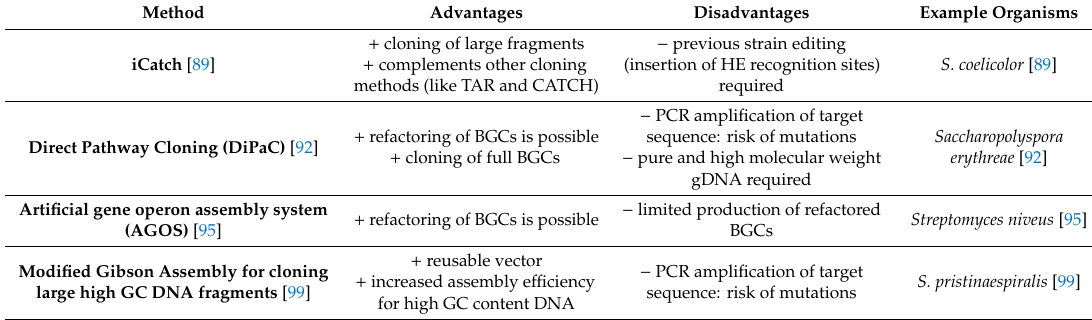
Table 1. Advantages and disadvantages of cloning strategies and example of successful